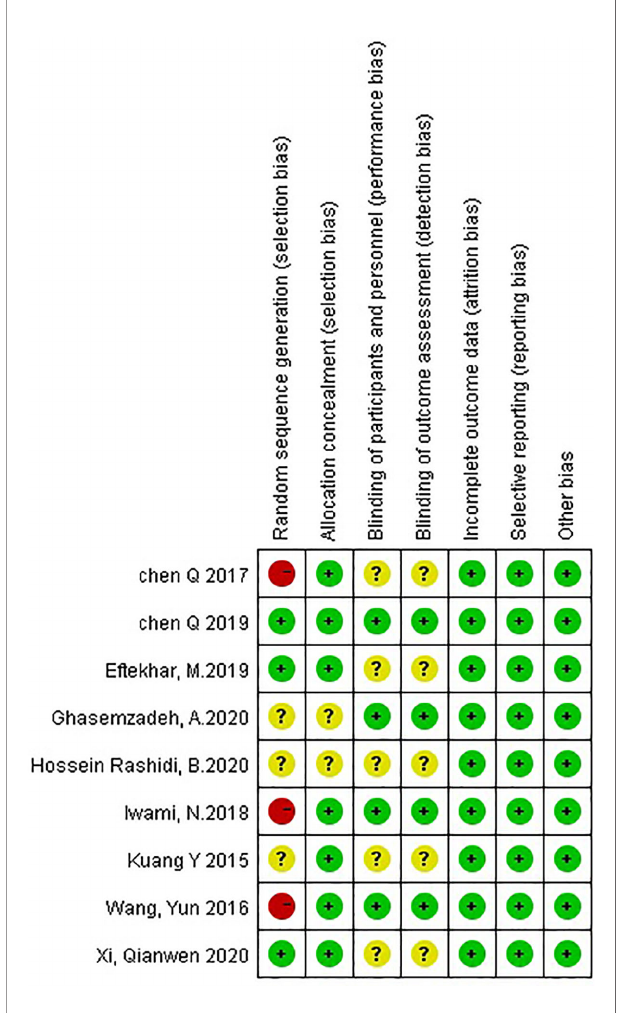
FIGURE 2 | Risk of bias assessment for the randomized